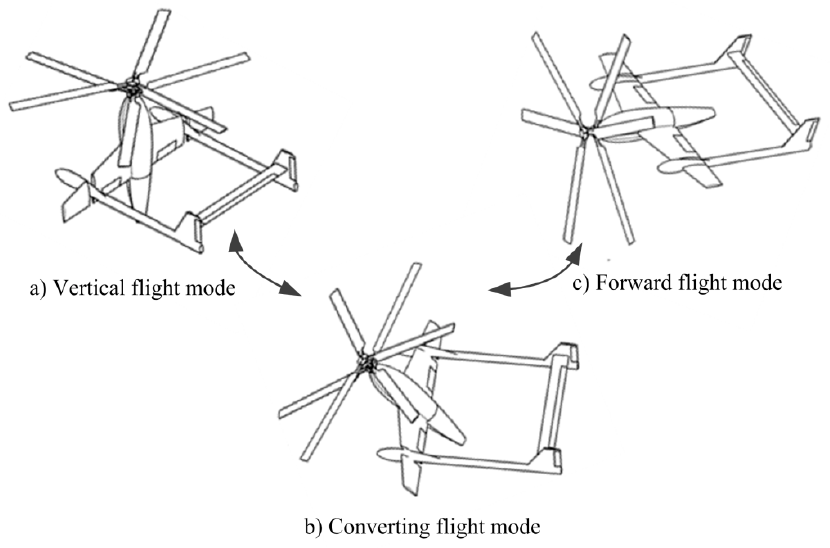
Figure 1. The mono tiltrotor (MTR) and its three flight modes.